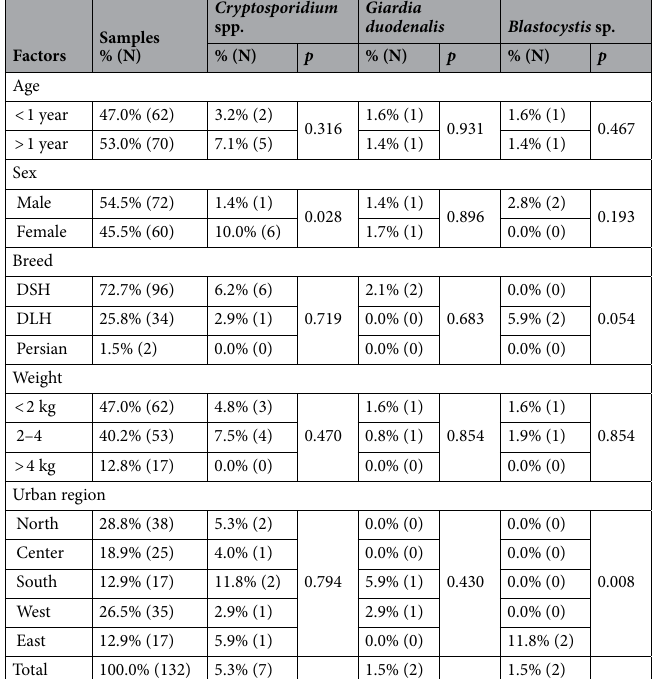
Giardia duodenalis Blastocystis